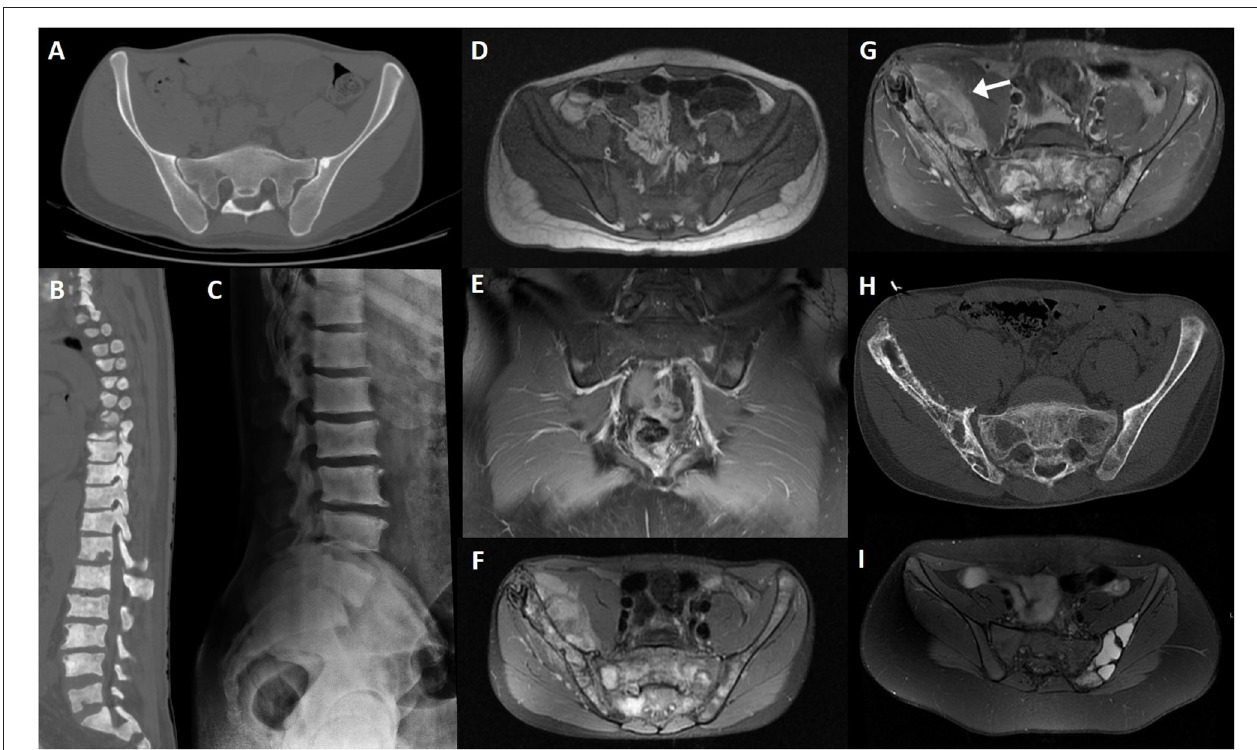
FIGURE 13 | CT axial slice (A) of an iliac bone enostosis mimicking peri-articular sclerosis; CT sagittal reconstruction (B) of the dorsal and lumbar spine in a patient with diffuse osteoblastic metastasis due to prostate cancer; lateral lumbar radiograph of the same patient (C) ; T1WI axial slice (D) ; and post-contrast fat-saturated T1WI coronal slice (E) of a patient with leukemic infiltration of the sacrum and iliac bones, showing diffuse bone marrow T1 hypointensity due to tumoral infiltration and multifocal patchy uptake, respectively; fat-saturated PD (F) , post-contrast fat-saturated T1WI (G) MRI and CT axial slice (H) of a 18-year-old male patient with Ewing sarcoma; fat-saturated PD (I) MRI sequence of an aneurysmatic bone cyst of the left iliac bone.